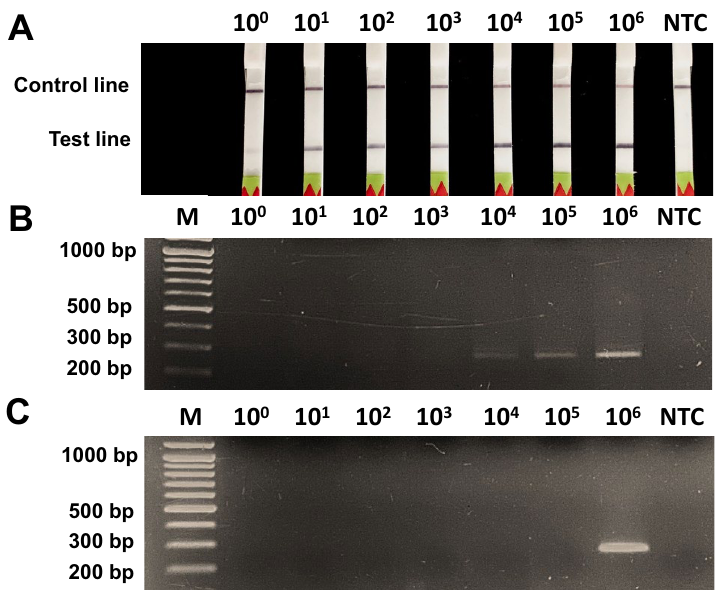
Figure 5. Analytical sensitivity of Babesia spp. detection among different approaches including ( A ) RPA- LFD using rpaBab264, ( B ) RPA-AGE and ( C ) cPCR using rpaBab264-AGE. Lane M is DNA ladder, The concentration of DNA used for sensitivity determination ranged from 2.25 × 10 0 to 2.25 × 10 6 copies/µl, NTC represents negative control (nuclease-free water).